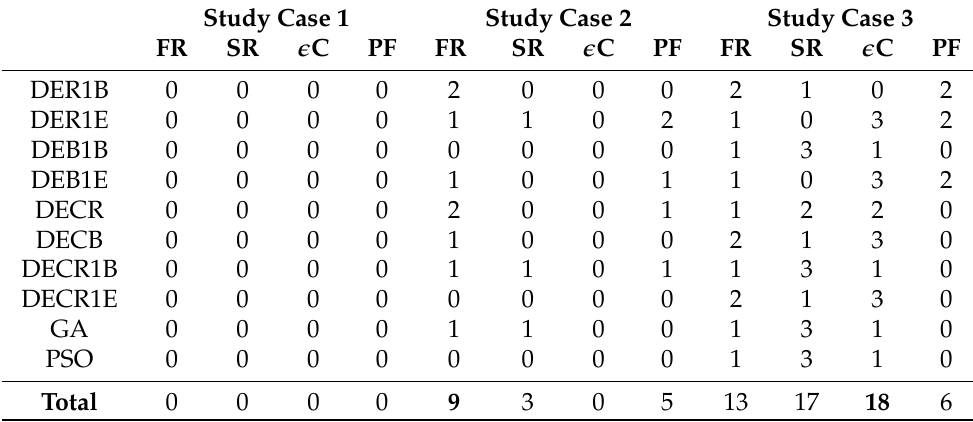
Table 10. Number of winners in the EVALS metric by using the multi comparative test.